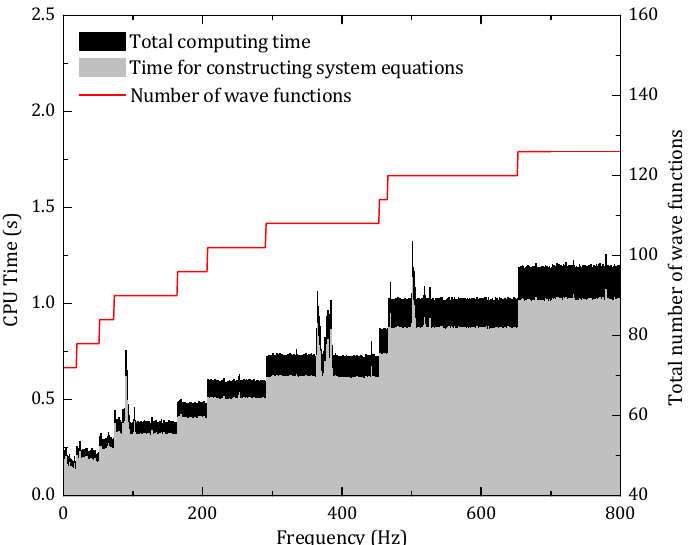
Figure 13. The CPU time and system DOFs of present method with respect to frequency.